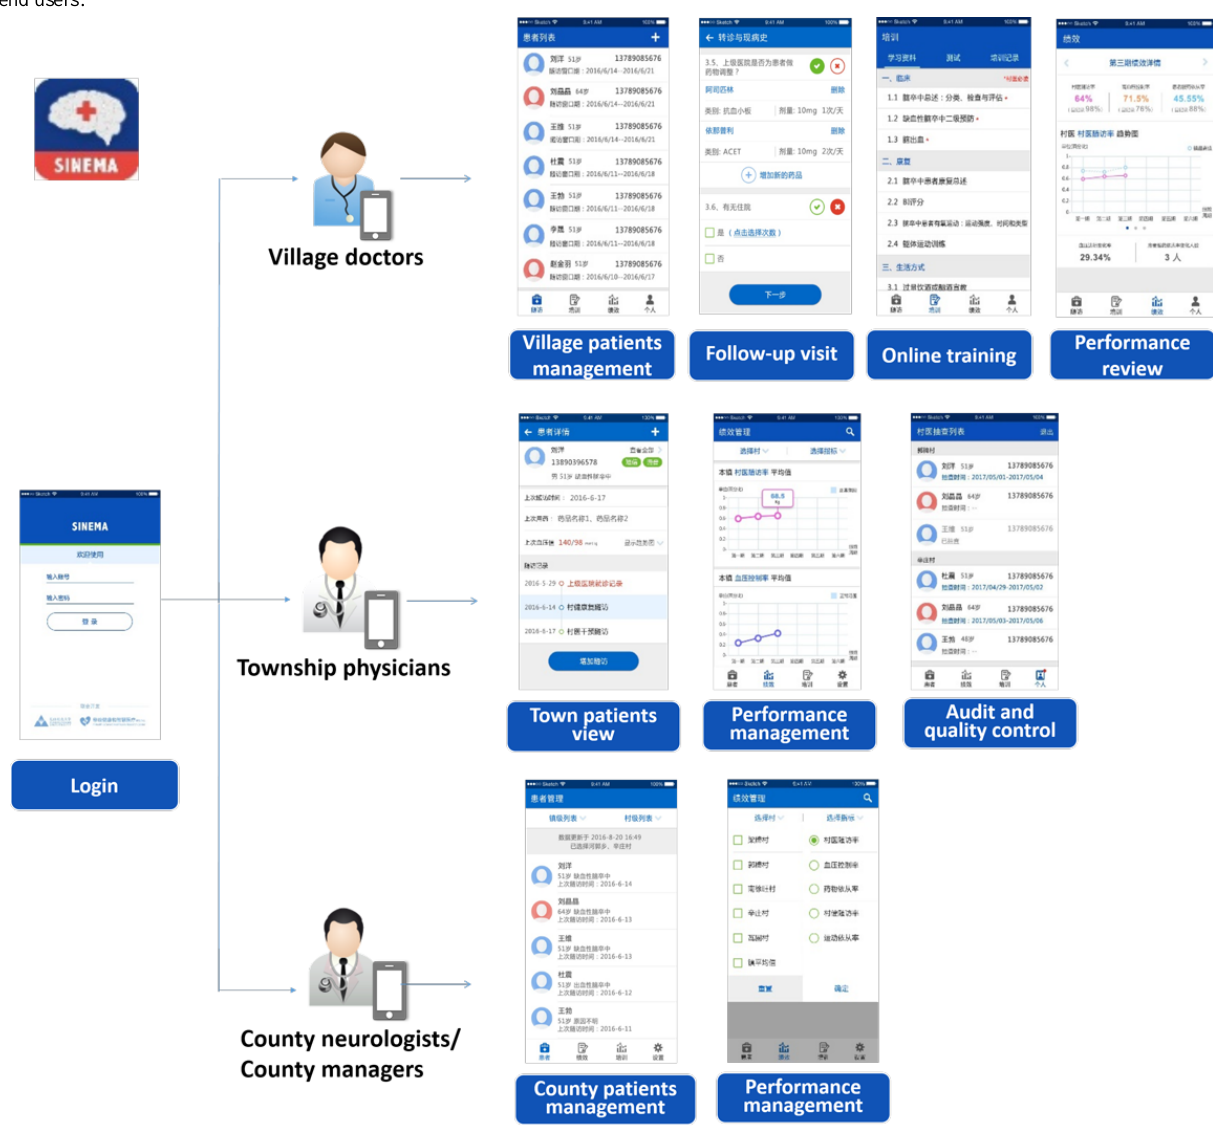
Figure 4. The screenshots showing the functional modules of system-integrated technology-enabled model of care mobile health app for the 3 types of end